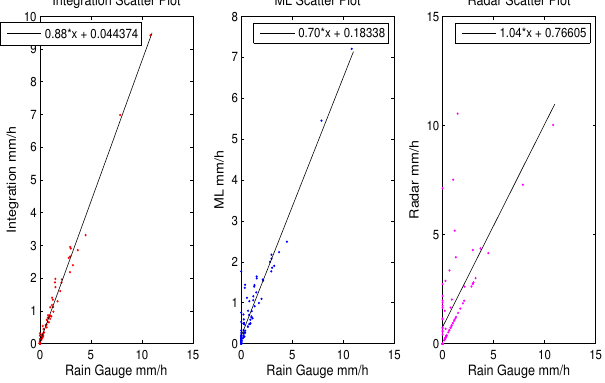
Figure 16. Rain rate scatter plots of the integration (left), ML (mid- Fig. 16. Rain rates scatter plots of the Integration (left), the ML (middle) and the radar (right) with respect to dle) and radar (right) with respect to the rain gauge at the Dorot site theraingaugeinDorotsiteforevent(3). for event 3.